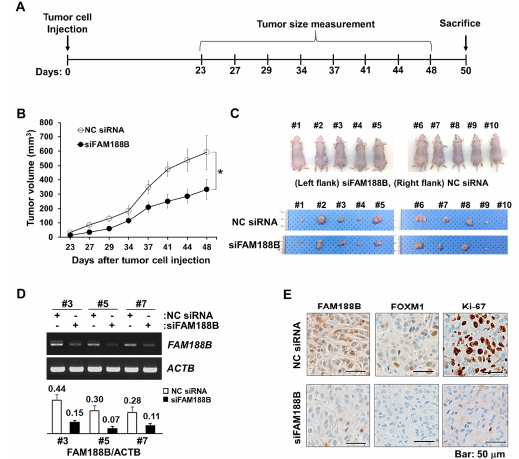
Figure 6. Effects of FAM188B knockdown on tumor growth mouse xenograft model. ( A ) Schematic procedure of in vivo experiments. A549 cells were transfected either with NC siRNA or siFAM188B for 48 h and cells were injected subcutaneously. ( B ) Two sets of experiments were shown, and the sizes of tumors were measured on indicated days (5 mice in each group). Error bars represent standard deviations. * p < 0.05 ( C ) The mice were sacrificed on day 50 and images of isolated tumors were captured. ( D ) Some tumors were processed for RT-PCR of FAM188B and levels of FAM188B were normalized by ACTB ( β -actin gene) as presented in the bar plot ( : NC siRNA, : siFAM188B). ( E ) Immunohistochemistry of FAM188B, FOXM1, and Ki-67 of representative tumor tissue (#7). Scale bar; 50 μ m. These experiments were performed two independent times with comparable results.